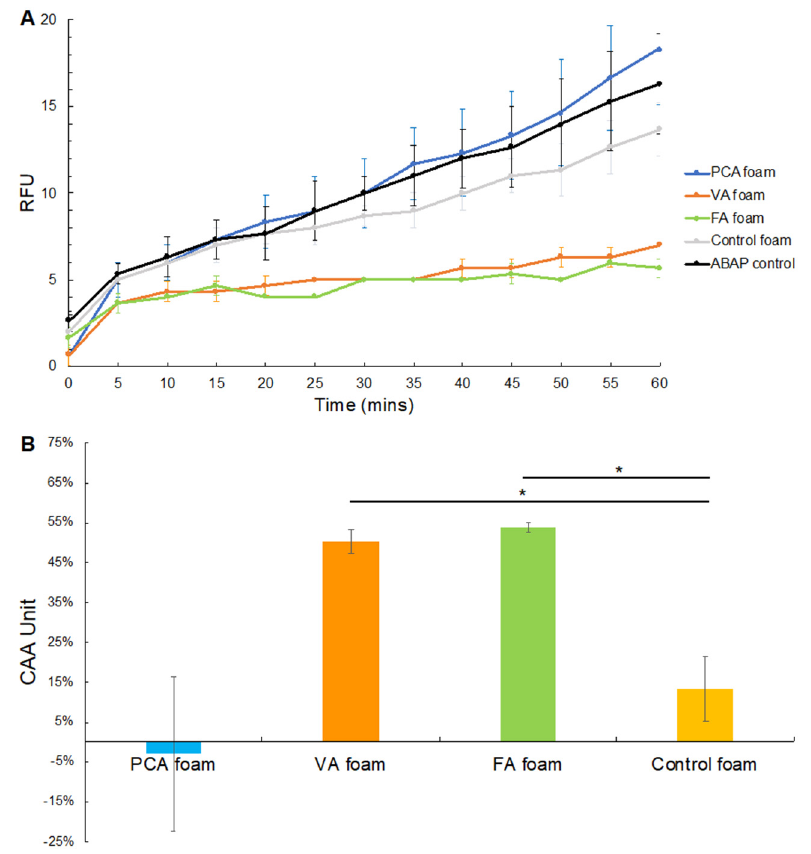
Figure 7. Cellular antioxidant analysis after PA foams and control foam incubation in ABAP. ( A ) Peroxyl radical-induced oxidation of DCFDA to DCF within Caco-2 cells over 60 min after incubation of ABAP with SMP foams, ( B ) Cellular antioxidant activity (CAA). n = 3, mean ± standard deviation displayed * p < 0.05 between H 2 O 2 exposed to PA foams and control foam.